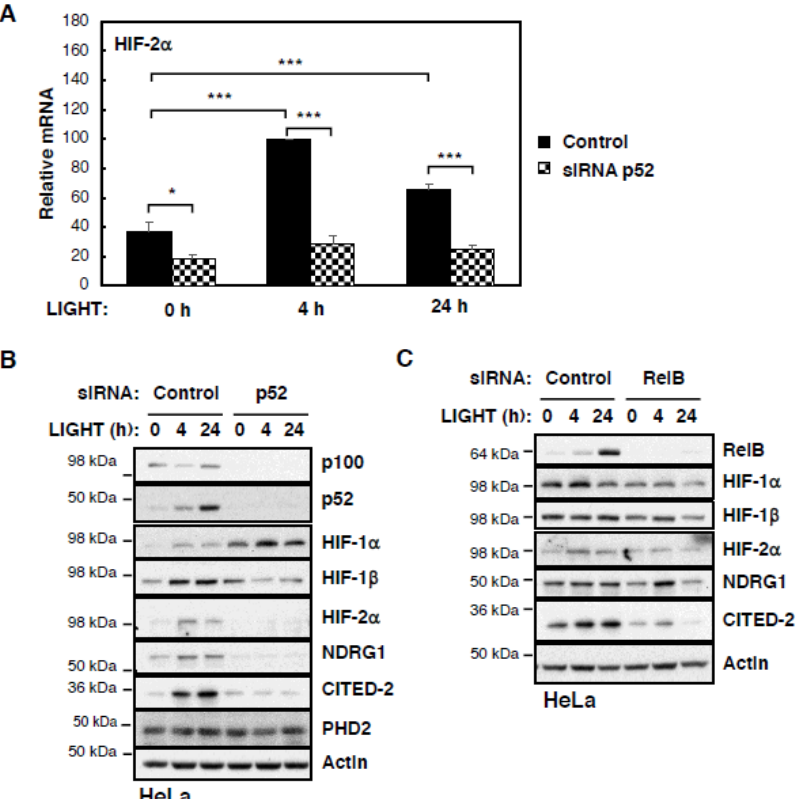
Figure 3. LIGHT-induced HIF-2 α expression is p52 dependent. ( A ) HeLa cells were transfected with siRNA control and p52 oligonucleotides and treated with 100 ng/mL LIGHT for the 0, 4, and 24 h prior mRNA extraction. RT-qPCR analysis for HIF-2 α gene transcript was performed, normalising to Actin mRNA levels. All of the values were normalised to the control treated with LIGHT for 4 h. The graph shows mean and SEM determined from at least three independent experiments. One-way Anova analysis was performed and significance determined as follows: * p ≤ 0.05, *** p ≤ 0.001. ( B , C ) HeLa cells were transfected with siRNA control and p52 ( B ) or RelB ( C ) oligonucleotides and treated with 100 ng/mL LIGHT for 0, 4, and 24 h. Whole cell lysates were prepared and analysed by western blot to investigate the protein expression of the HIF subunits and a subset of HIF specific targets following treatment. β -Actin was used as loading control.